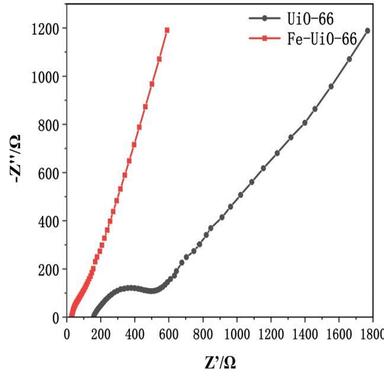
EIS Nyquist plots of UiO-66 and Fe-UiO-66.